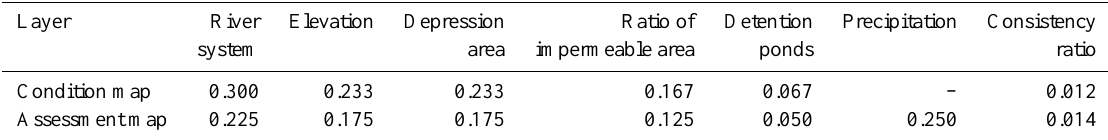
Table 1. Assigned weights for the layers.